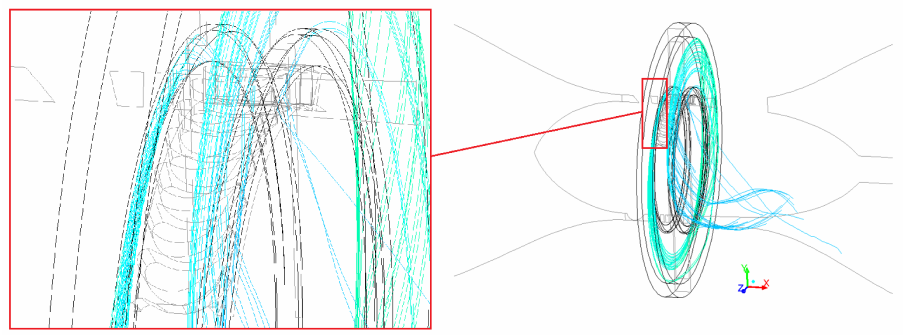
Figure 17. Visualization of streamlines through the clearance between rotor disk and casing.